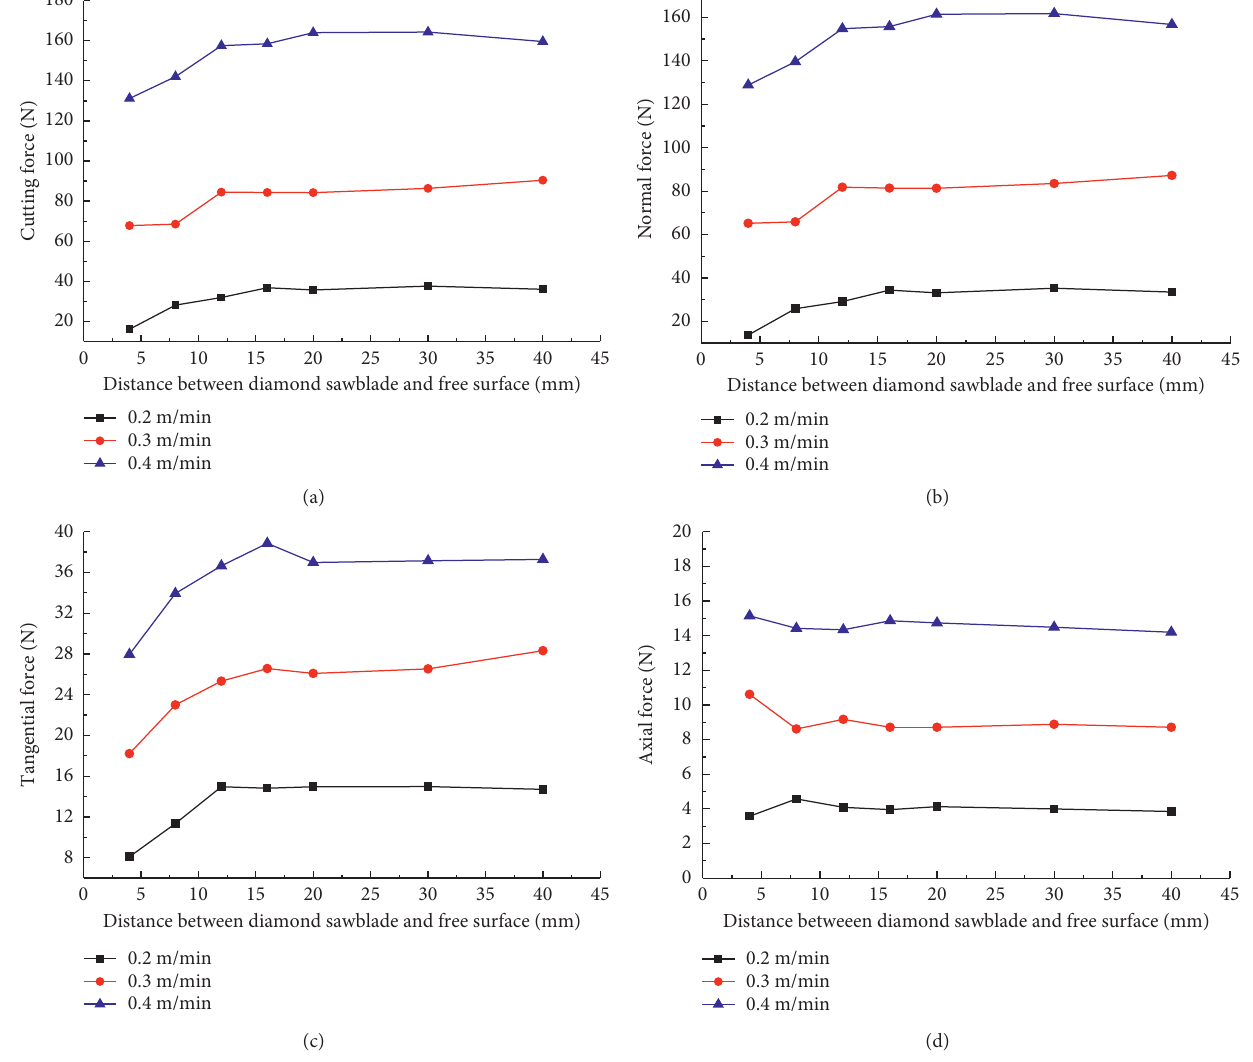
Figure 5: Vertical cutting force of the diamond sawblade into rock and variation curve of distance between the sawblade and rock free surface. (a) Variation curve of average cutting force and distance between the sawblade and free surface. (b) Variation curve between average normal force and distance between the sawblade and rock free surface. (c) Variation curve between average tangential force and distance between the sawblade and free surface. (d) Variation curve between the average axial force and sawblade to rock free